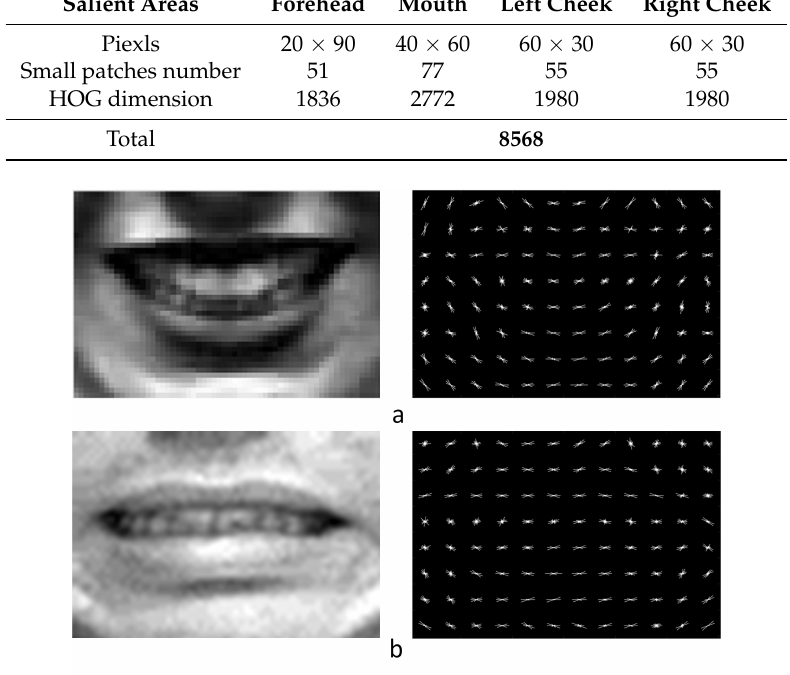
Figure 6. HOG descriptors of the mouths. ( a ) Happy mouth areas; ( b ) Fear mouth